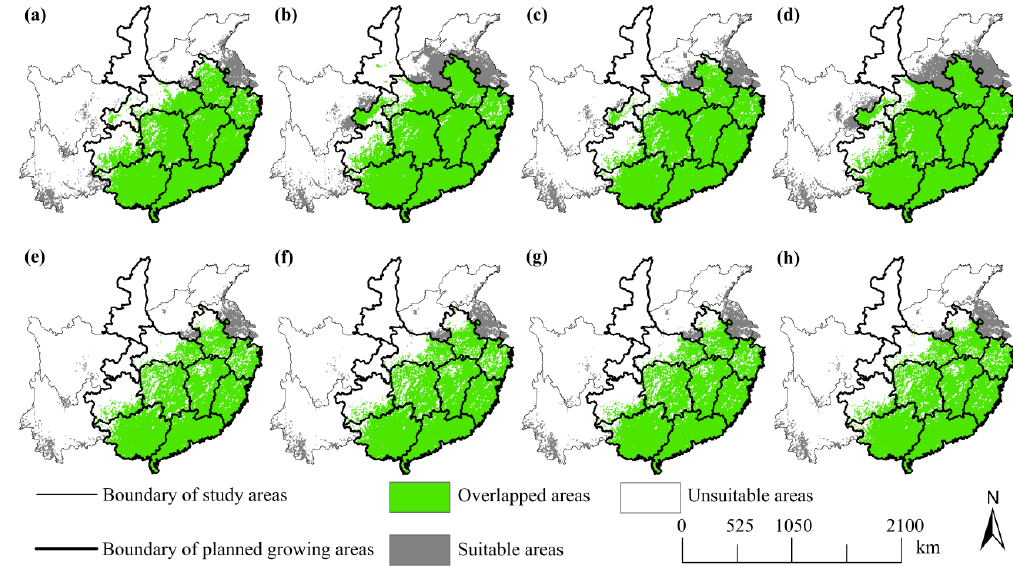
Figure 4. Overlap between planned growing areas and predicted suitable habitats of Sapindus mukorossi in China based on various modeling set-ups: ( a ) full dispersal × average GCMs × RCP2.6; ( b ) full dispersal × average GCMs × RCP8.5; ( c ) full dispersal × consensus GCMs × RCP2.6; ( d ) full dispersal × consensus GCMs × RCP8.5; ( e ) no dispersal × average GCMs × RCP2.6; ( f ) no dispersal × average GCMs × RCP8.5; ( g ) no dispersal × consensus GCMs × RCP2.6; and ( h ) no dispersal × consensus GCMs × RCP8.5.